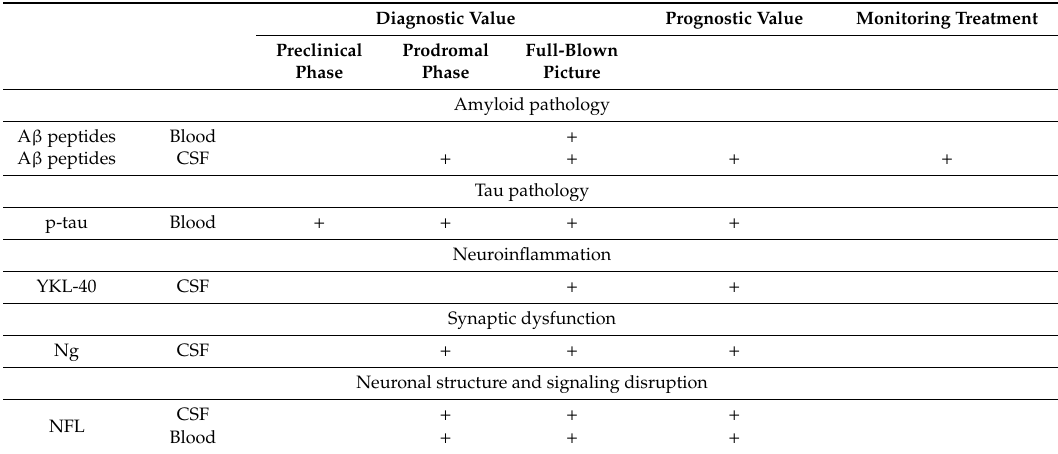
Table 2. Overview on the possible context of use of fluid biomarkers in AD. Diagnostic